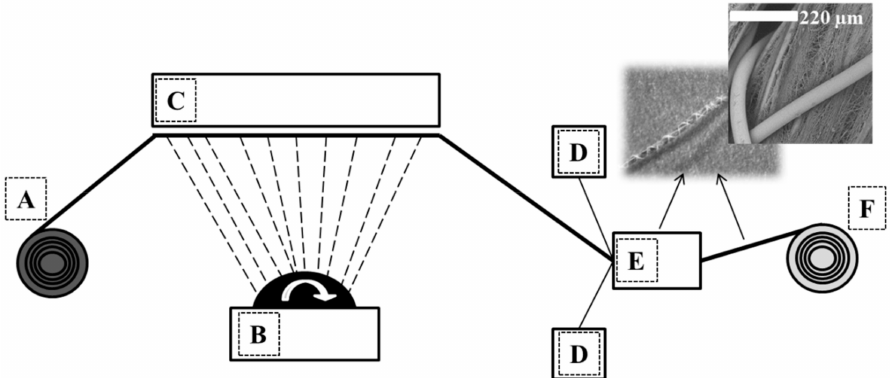
Figure 5. Diagram of a nanofiber-covered-yarn production device. ( A ): Textured core yarn, ( B ): roller electrospinning system, ( C ): collector, ( D ): application of protective yarn(s), ( E ): Twisting of protective yarn, and ( F ): take-up